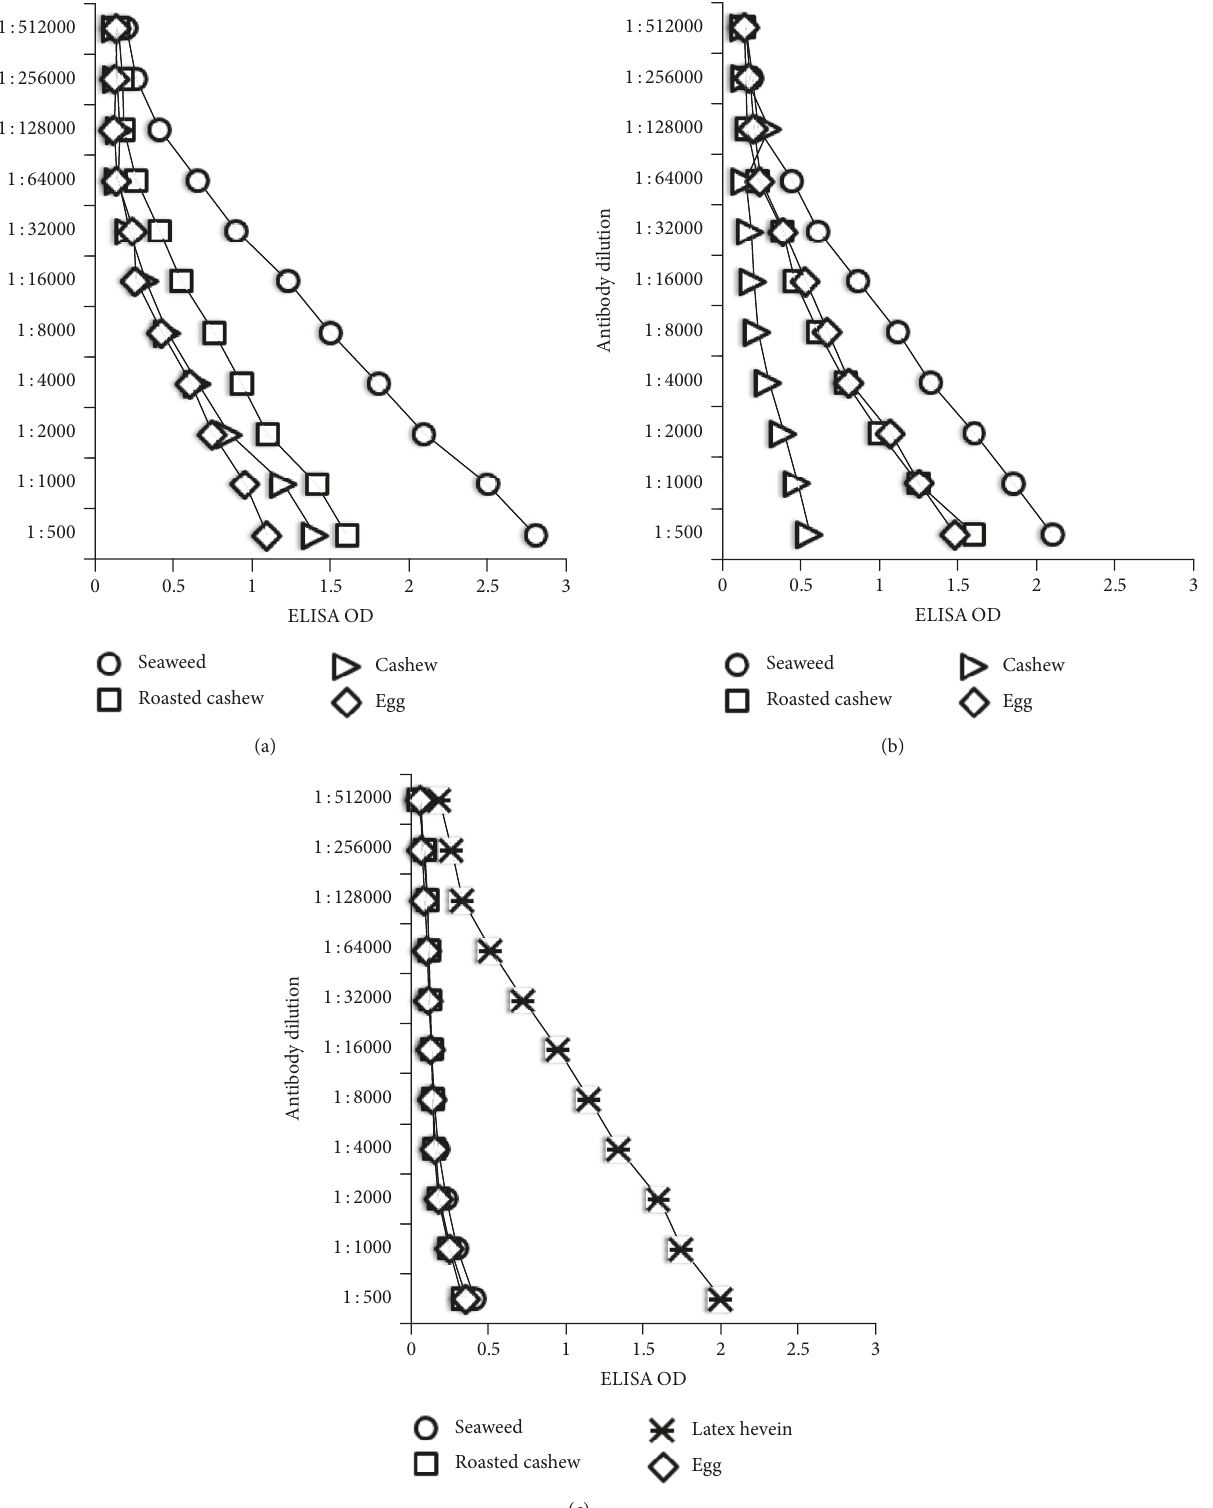
Figure 1: The binding of serially diluted T3 (a), T4 (b), and Tg (c) monoclonal antibodies to the same concentration of different food